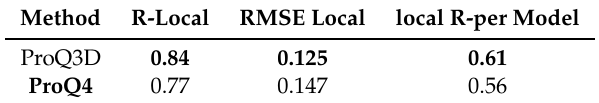
Table A3. Local-score performance comparison of ProQ4 and ProQ3D on CASP11 [21].